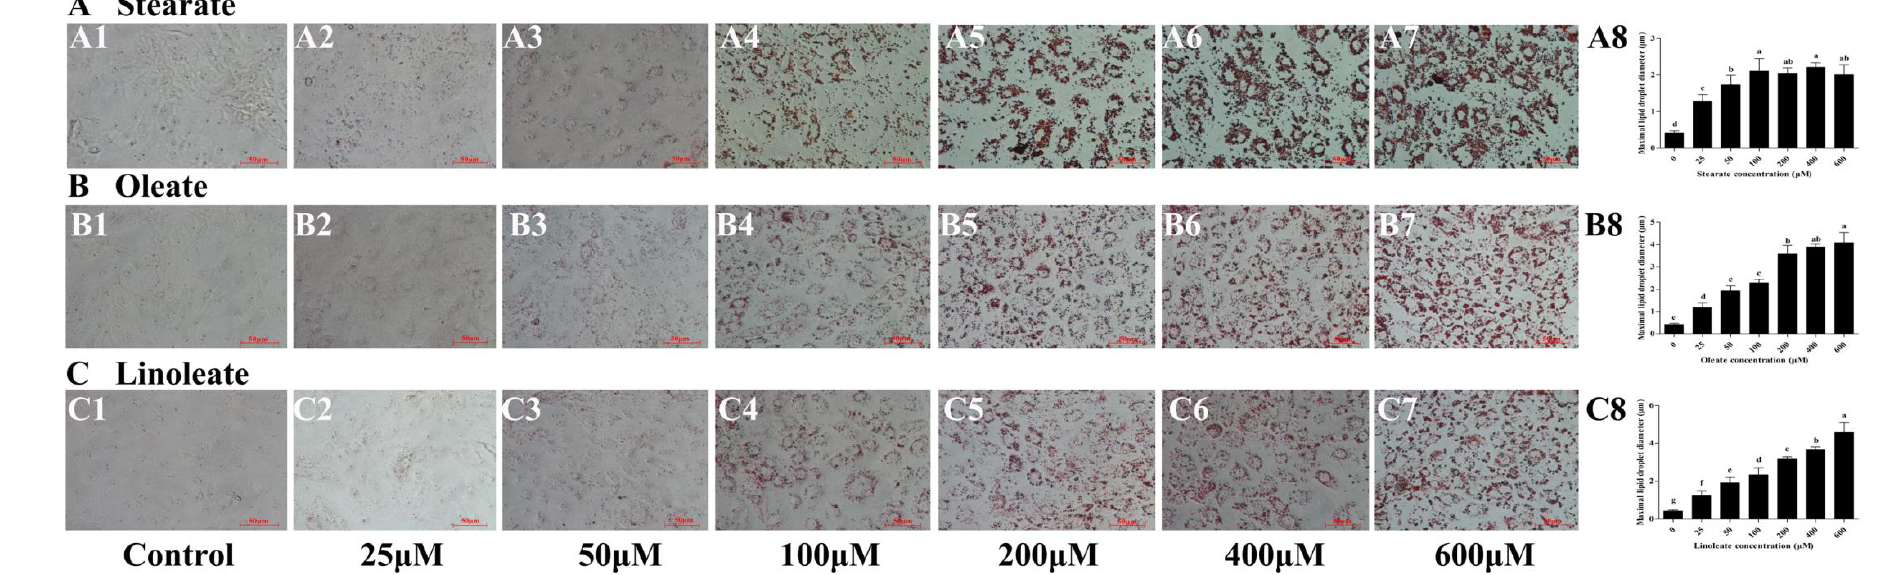
Figure 3. Effect of stearate, oleate and linoleate on lipid droplet formation in pMECs. Cells were incubated with 0 (control), 25, 50, 100, 200, 400 and 600 μM stearate ( A ), oleate (B ) or linoleate ( C ), respectively, for 24 h, and then stained with oil red O and visualized by light microscopy with 400 × magnification. (A1), 0 μM stearate (Control); (A2), 25 μM stearate; (A3), 50 μM stearate; (A4), 100 μM stearate; (A5), 200 μM stearate; (A6), 400 μM stearate; (A7), 600 μM stearate; (A8), maximal lipid droplet diameter in the cells with 0 (control), 25, 50, 100, 200, 400 and 600 μM stearate; (B1), 0 μM oleate (Control); (B2), 25 μM oleate; (B3), 50 μM oleate; (B4), 100 μM oleate; (B5), 200 μM oleate; (B6), 400 μM oleate; (B7), 600 μM oleate; (B8), maximal lipid droplet diameter in the cells with 0 (control), 25, 50, 100, 200, 400 and 600 μM oleate; (C1), 0 μM linoleate (Control); (C2), 25 μM linoleate; (C3), 50 μM linoleate; (C4), 100 μM linoleate; (C5), 200 μM linoleate; (C6), 400 μM linoleate; (C7), 600 μM linoleate; (C8), maximal lipid droplet diameter in the cells with 0 (control), 25, 50, 100, 200, 400 and 600 μM linoleate. In A8, B8 and C8, data are expressed as mean ± SD ( n = 5), and comparisons between groups were performed via ANOVA and Tukey’s range test for multiple com- parisons. Different letters indicate statistical significance between different concentrations of stearate, oleate and linoleate treatment groups ( p < 0.05).